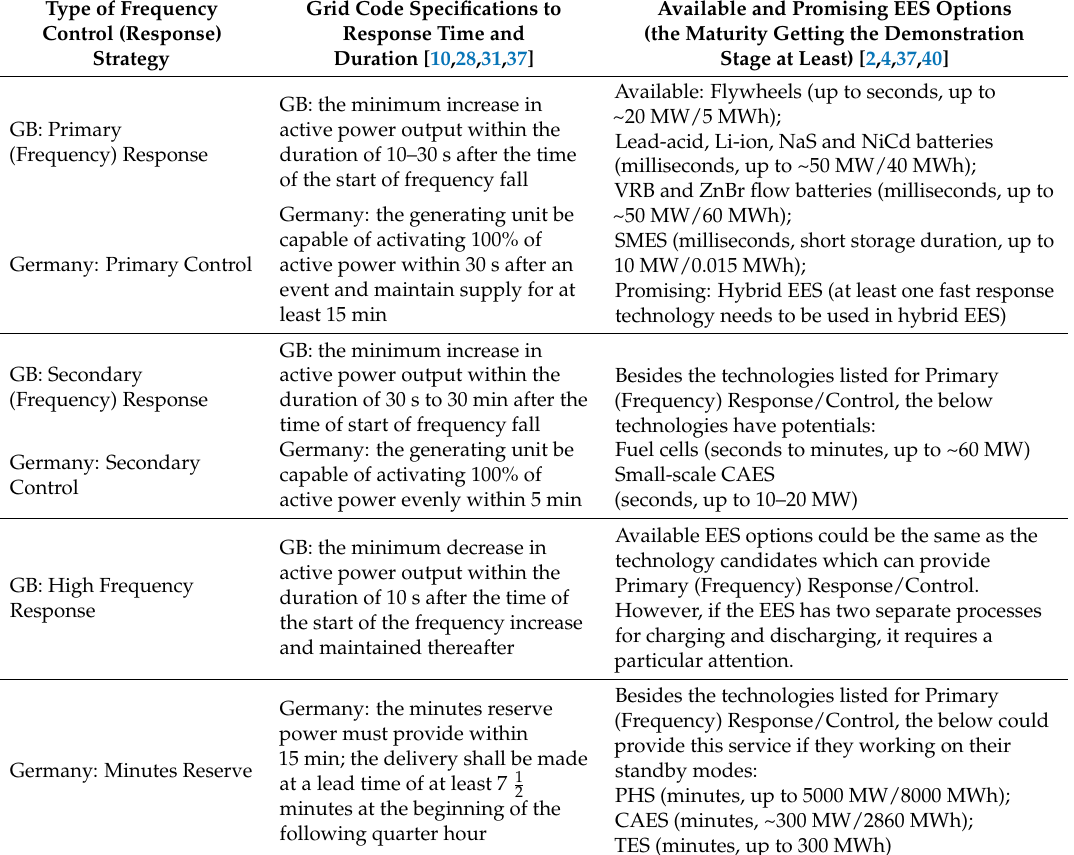
Table 9. EES options for providing frequency control to meet GB and Germany Grid